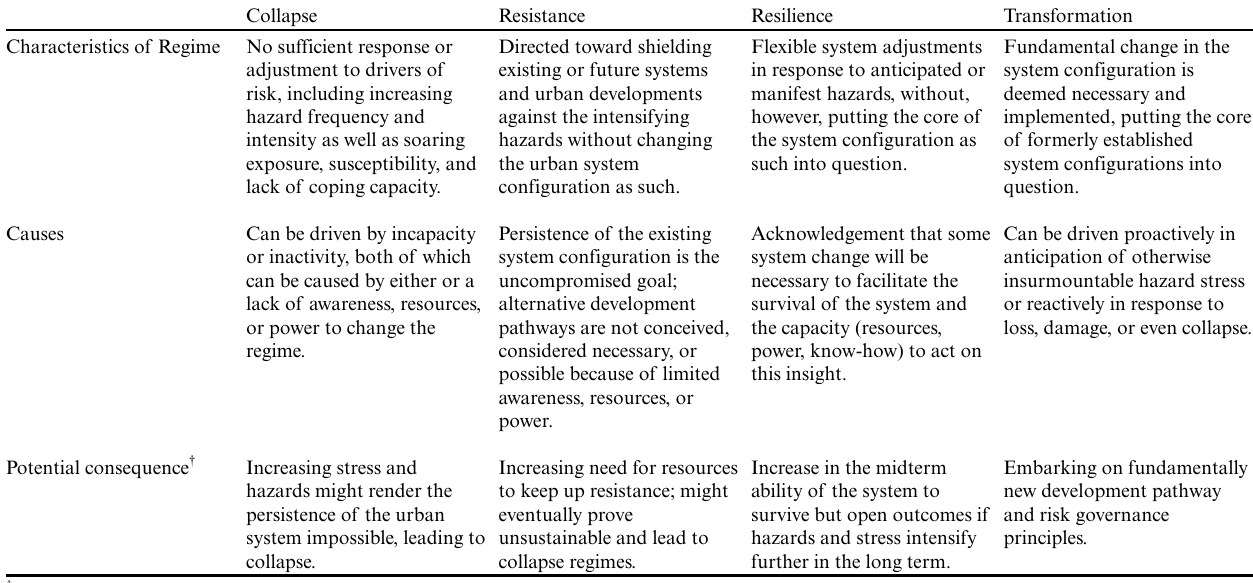
Table 1 . Risk management characteristics, causes, and potential consequences of each regime.